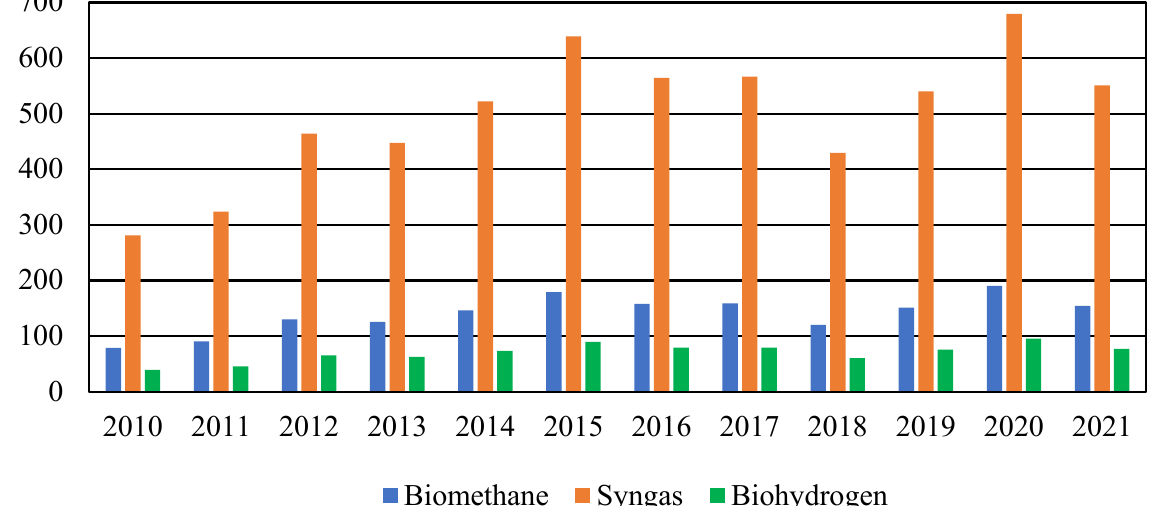
Figure 5. The potential of gas-like types of biofuels obtained from crop production by-products in Lithuania (mln. m 3 /year).